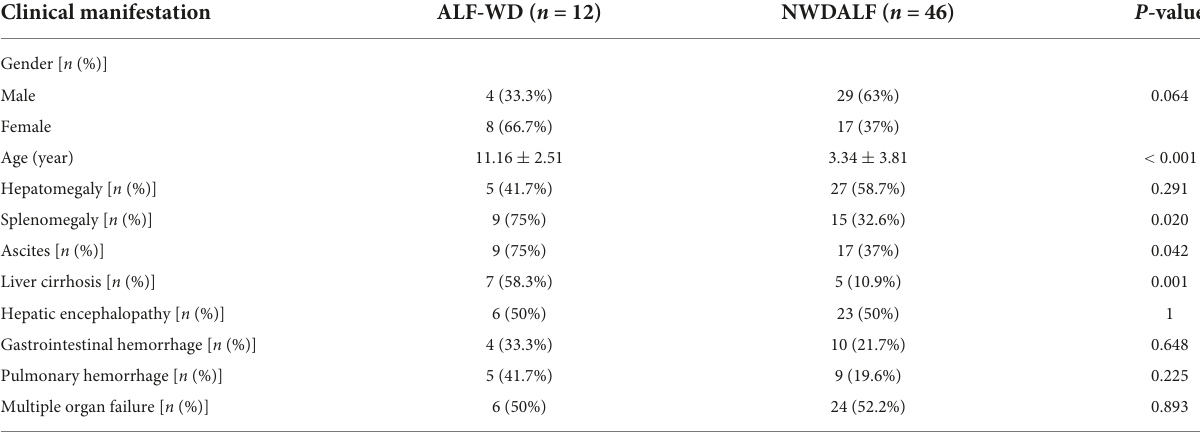
TABLE 2 Comparison of clinical manifestations between ALF-WD and NWDALF.